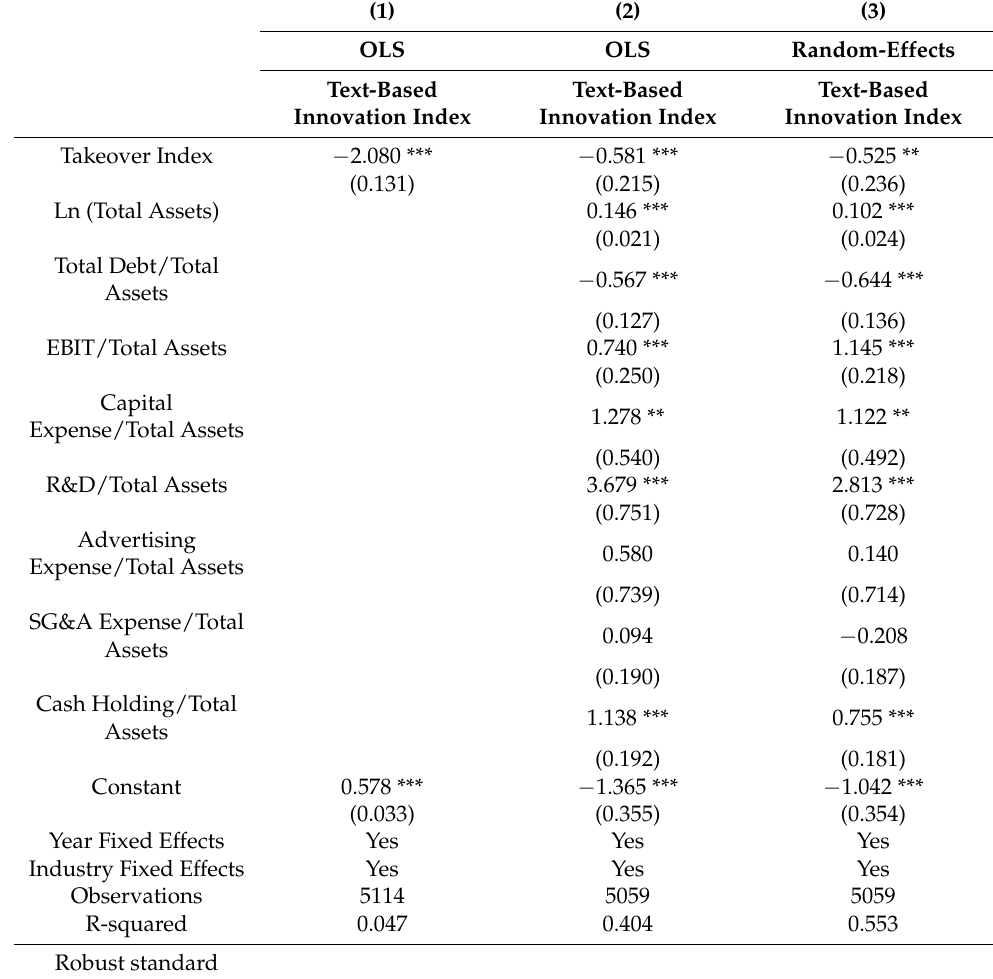
Table 2. The effect of the hostile takeover on text-based innovation index as a proxy for corporate